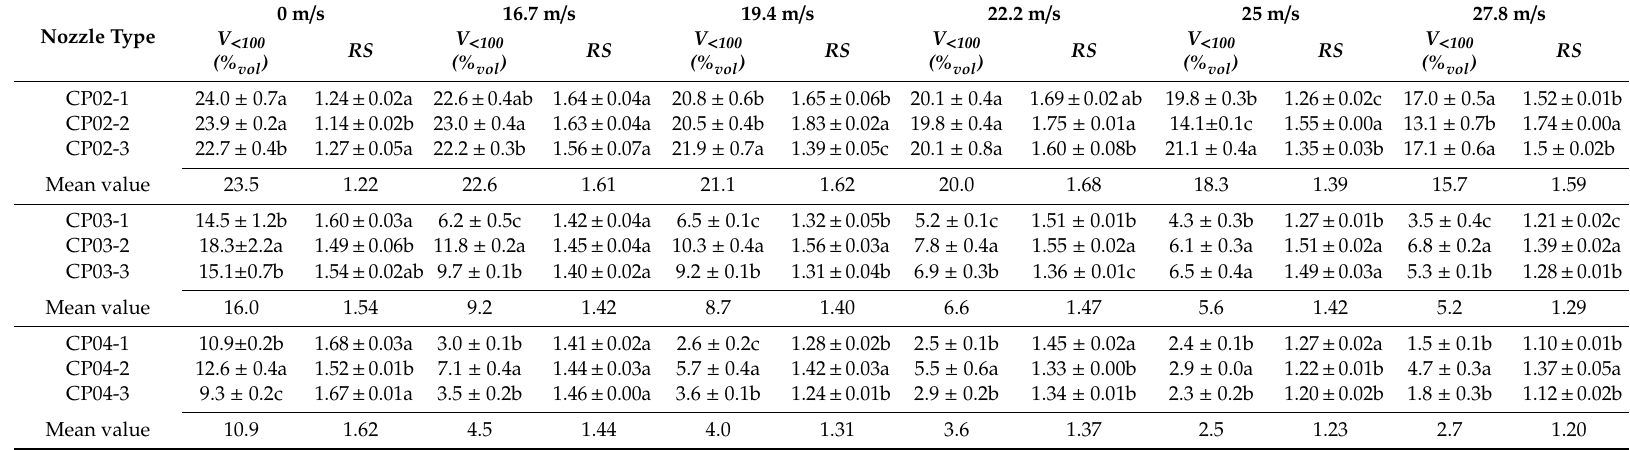
Table 4. Related droplet parameter for spray measured at six airflow velocities for each type of the three individual